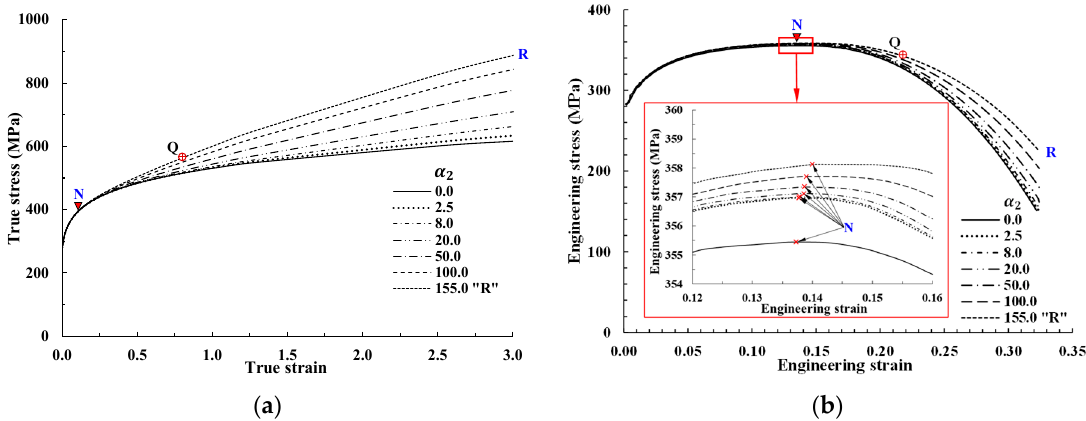
Figure 5. Flow curves and their corresponding tensile behaviors at various 𝛼 (cid:2870) values with 𝑛 (cid:2870) fixed at 3.0: ( a ) Flow curves controlled by 𝛼 (cid:2870) when 𝑛 (cid:2870) is fixed at 3.0; ( b ) predicted tensile behavior according to the flow curves in Figure 5a.